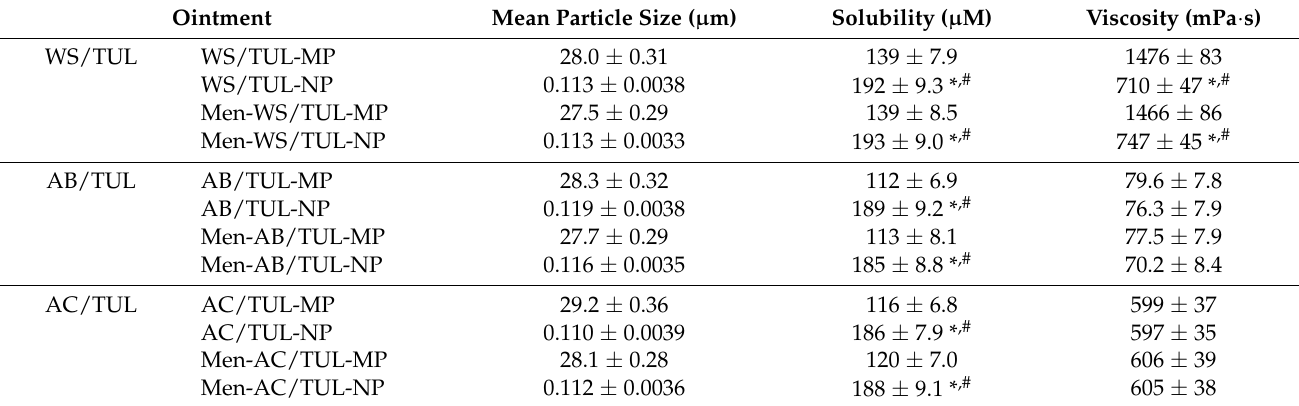
Table 2. Changes in particle size, solubility, and viscosity of WS/TUL, AB/TUL, and AC/TUL ointments with and without l